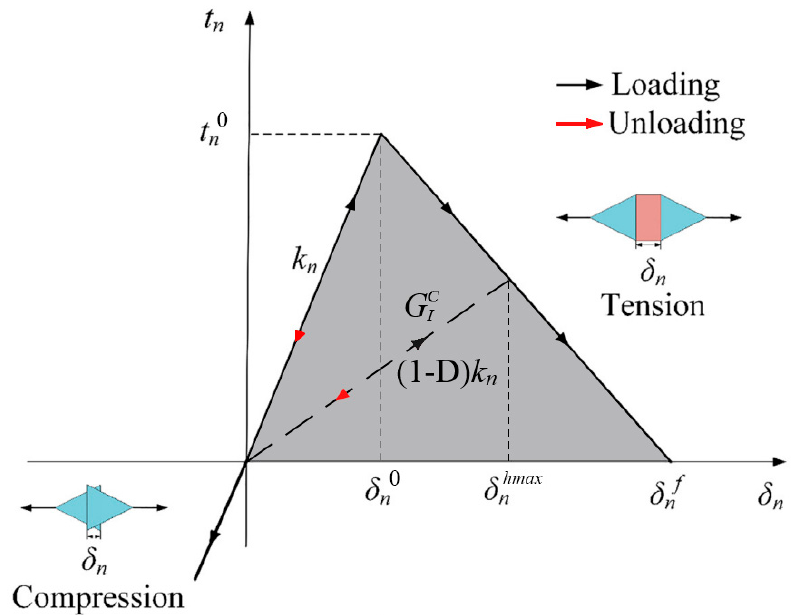
Figure 1. Constitutive relationship of the cohesive zone element.